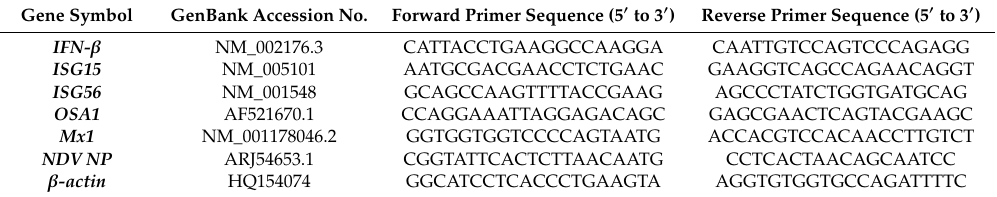
Table 1. Sequence of gene mRNA primers for RT-qPCR.